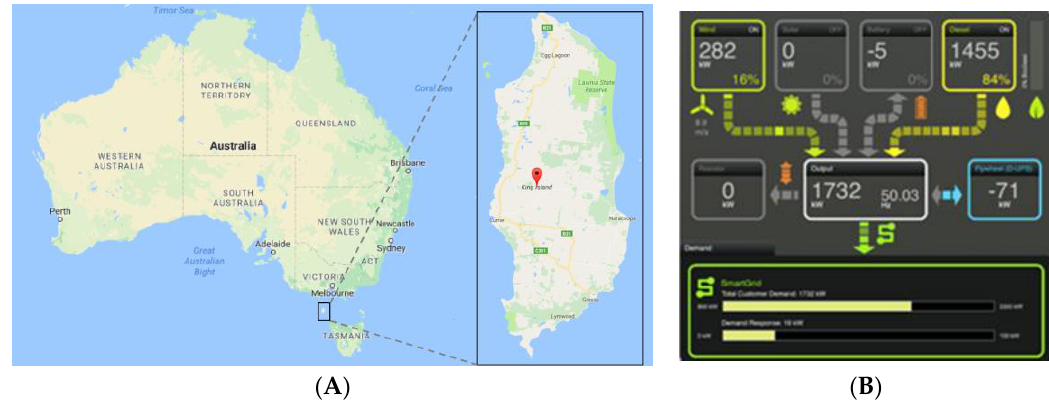
Figure 3. The location of King Island in Australia ( A ); and the current arrangement of hybrid energy portfolio set for the Island ( B ).